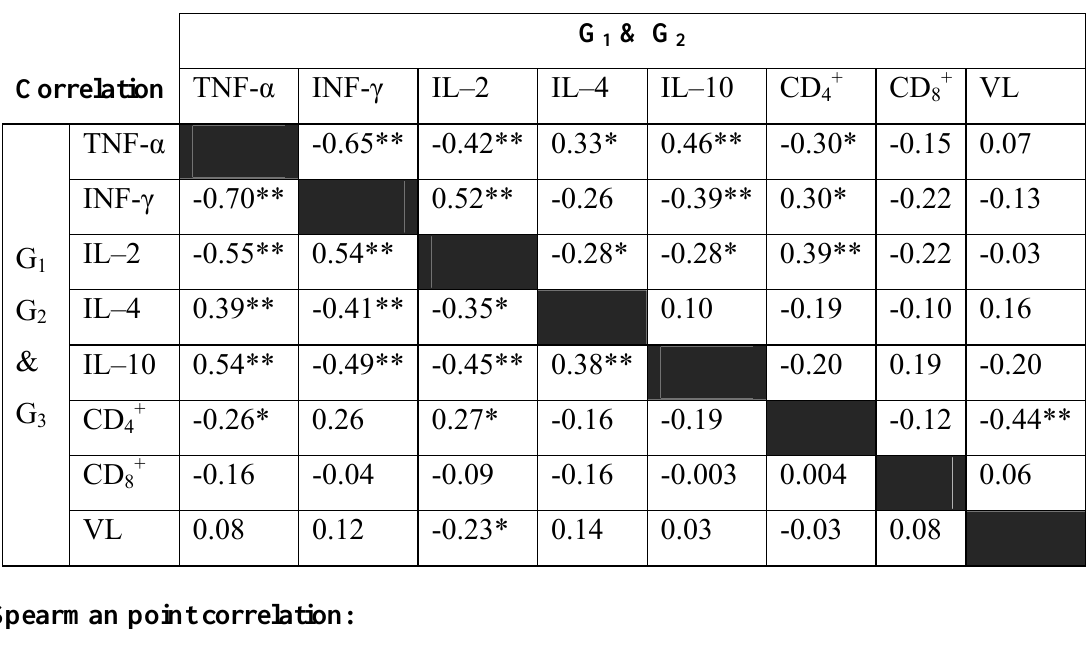
Table 2. Linear correlation between pairs of variables (TNF- α ; INF- γ ; IL-2; IL-4; IL-10; CD 4+ /mm 3 ; CD 8+ /mm 3 ; and viral load – VL), when two different group combinations were & G ; and G , G & G considered: G 1 2 1 2 3